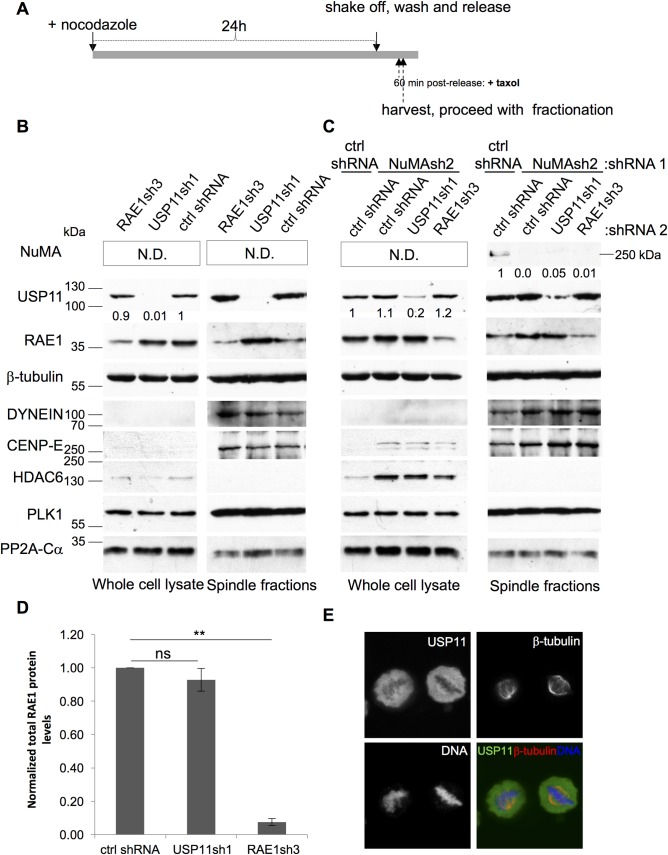
RAE1 and USP11 are associated with the mitotic spindle.(A) Schematic representation of experimental workflow of mitotic spindle isolation. U2OS cells expressing indicated shRNAs were treated with nocodazole for 24h. Mitotic cells were washed off, released and treated briefly with taxol before harvesting. Spindle fractionation was done as described previously ([35, 36], see Material and Methods). The western blots shown are representative of the results obtained for three independent biological replicates. (B) Purified mitotic spindles were separated by SDS-PAGE (11%) and the indicated proteins were detected by western blot. Knock-down of USP11 does not affect mitotic spindle localization of RAE1. The numbers underneath the USP11 western blot indicate the normalized USP11 protein levels in each sample. (C) Purified mitotic spindles from U2OS cells transduced with the indicated shRNAs, were separated on a 7.5% SDS-PAGE gel and transferred onto nitrocellulose for Western blot detection. Representative western blots of protein knock-downs of the transductions used to quantify bi/multi-polar spindles in Fig 6. Antibodies used are indicated to the right of the western blots. Positive controls for mitotic spindle isolation were included (ß-tubulin, DYNEIN, CENP-E, PLK1 and PP2A-Calpha) as well as the chromatin modifier, HDAC6, which was previously shown not to associate with mitotic spindles [35]. Mw markers are indicated to the left of the western blots. The numbers underneath the USP11 and NuMA western blots illustrate the normalized protein levels of USP11 and, respectively, NuMA. (D) USP11 does not influence RAE1 association with the mitotic spindle. The amount of RAE1 associated with mitotic spindles upon USP11 or RAE1 knock-down was quantified, normalized to the loading control and compared to cells treated with control shRNA (n = 4). Averages and SEM of four independent knock-down and fractionations are shown. P-values were calculated using the two-tailed paired t-test; compared to the control shRNA transduced cells, and are indicated as follows: ns: p > 0.05; **: 0.0001 < p < 0.001. (E) U2OS cells were treated with nocodazole for 24 h, the cells were carefully washed with pre-warmed PBS and treated with 5 μM MG132 for 90 min before fixation. Immunostaining of endogenous USP11, ß-tubulin and DNA was done as described in Materials and Methods.